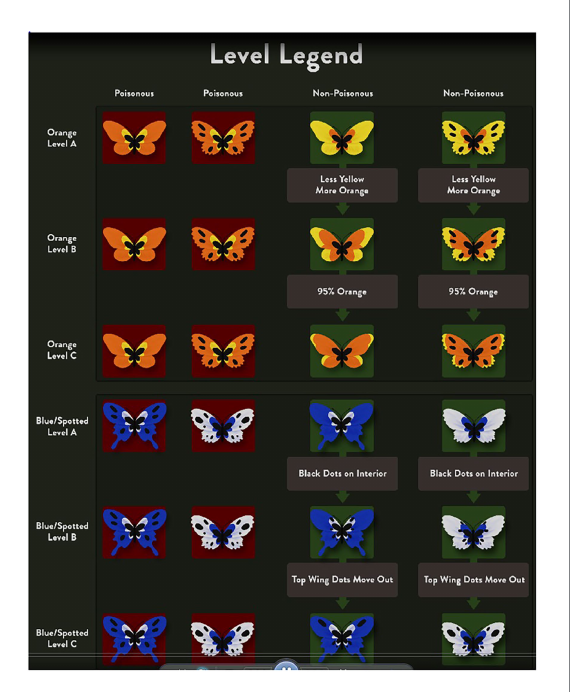
FIGURE 3 The level legend showing how the butterflies differed across levels and between poisonous and non-poisonous